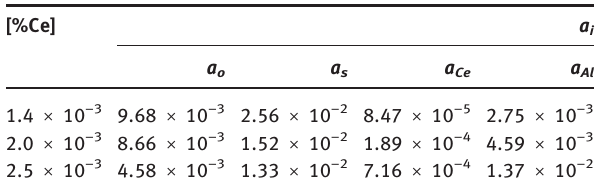
Table 8: Calculated values of Δ G for eqs (12) and (14) at 1,873K.